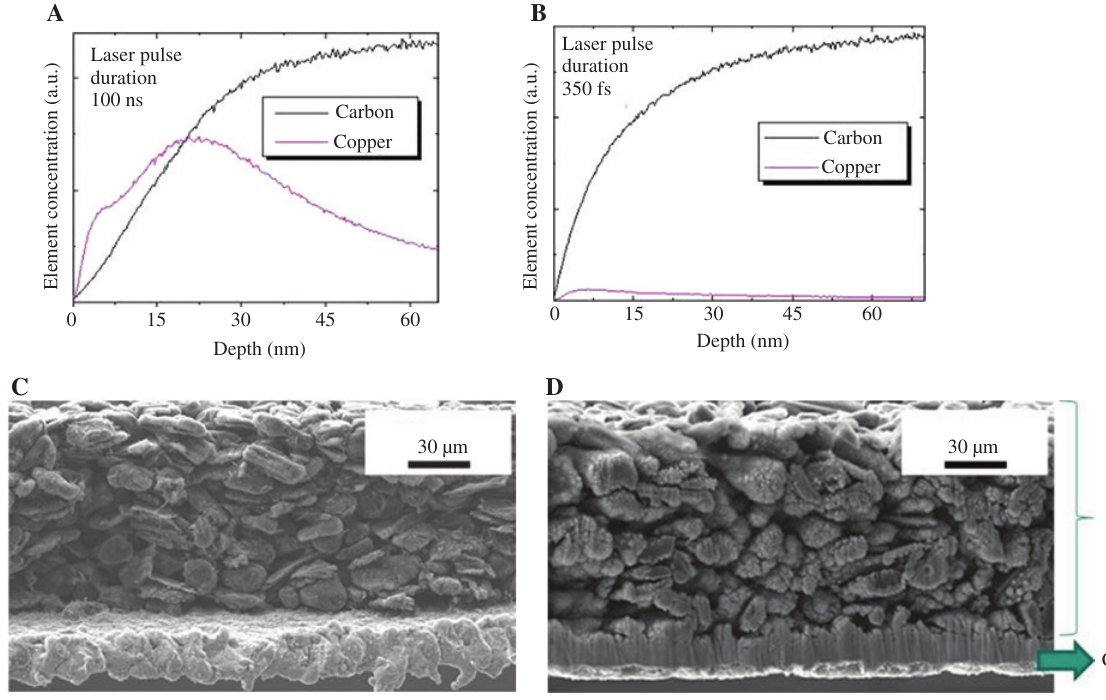
Figure 9: Laser cutting of single-side coated graphite anode. (A, B) TOF-SIMS depth profile close to the cut edge on top of the electrode layer: (A) cutting with ns-laser radiation (pulse length 100 ns and (B) cutting with ultrafast laser radiation (pulse length 350 fs). (C, D) SEM image of cut edges produced by (C) ns-laser radiation (100 ns) and (D) by ultrafast laser radiation. Reprinted from